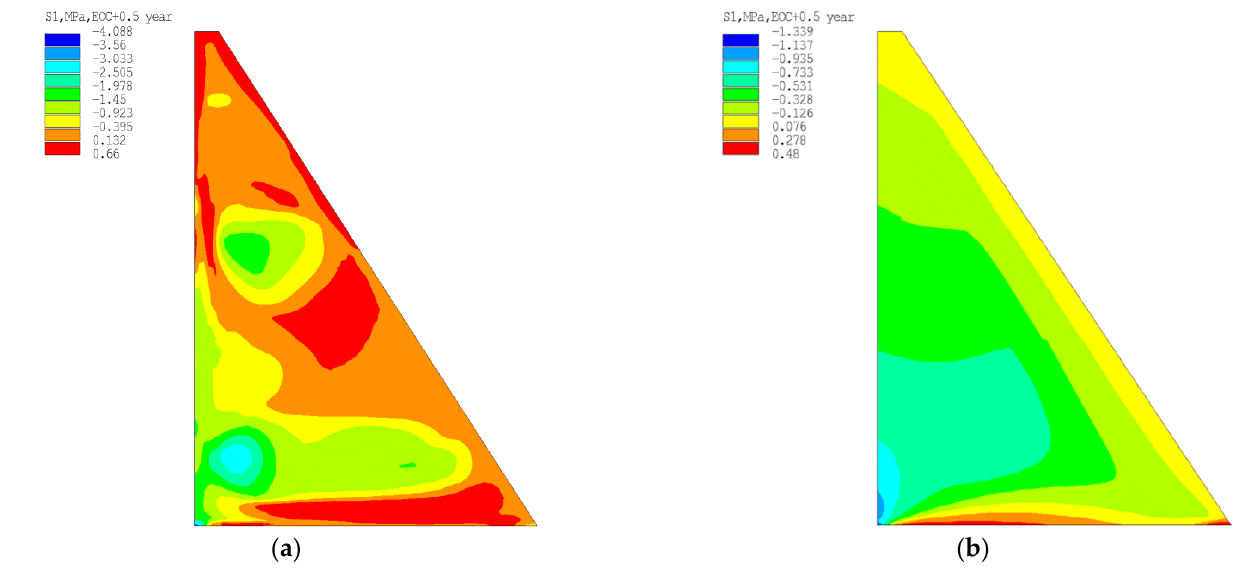
Figure 16. The main maximum stresses in the dam: ( a ) Stresses when calculating with regard to temperature factors; ( b ) Stresses when calculating excluding temperature factors.